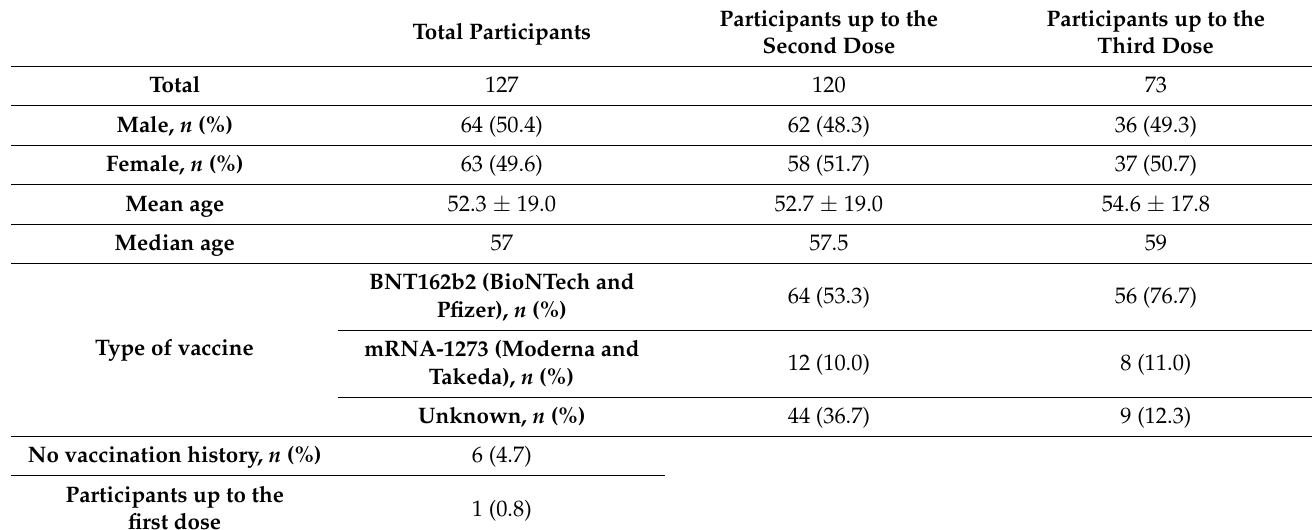
Table 1. Participant characteristics up to the second and third vaccine doses. Participants up to Total Participants